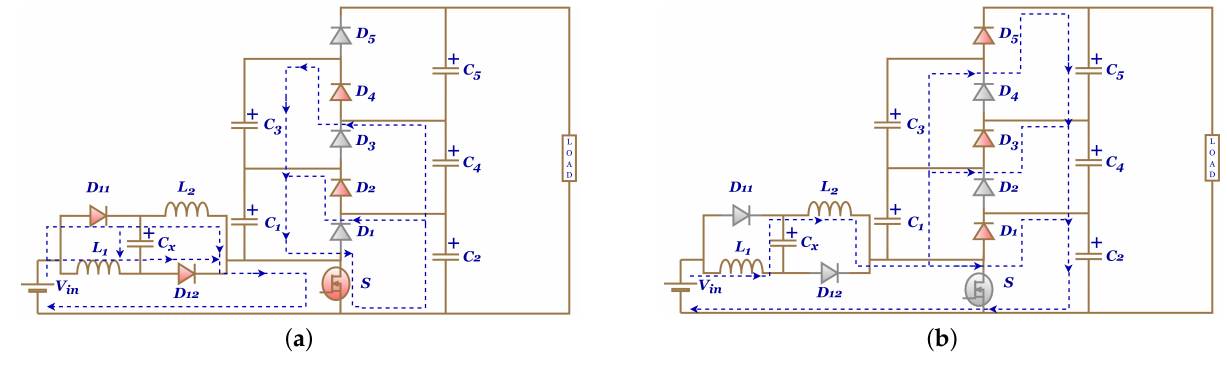
Figure 6. 1st M-TBC operation: ( a ) S closed and ( b ) S